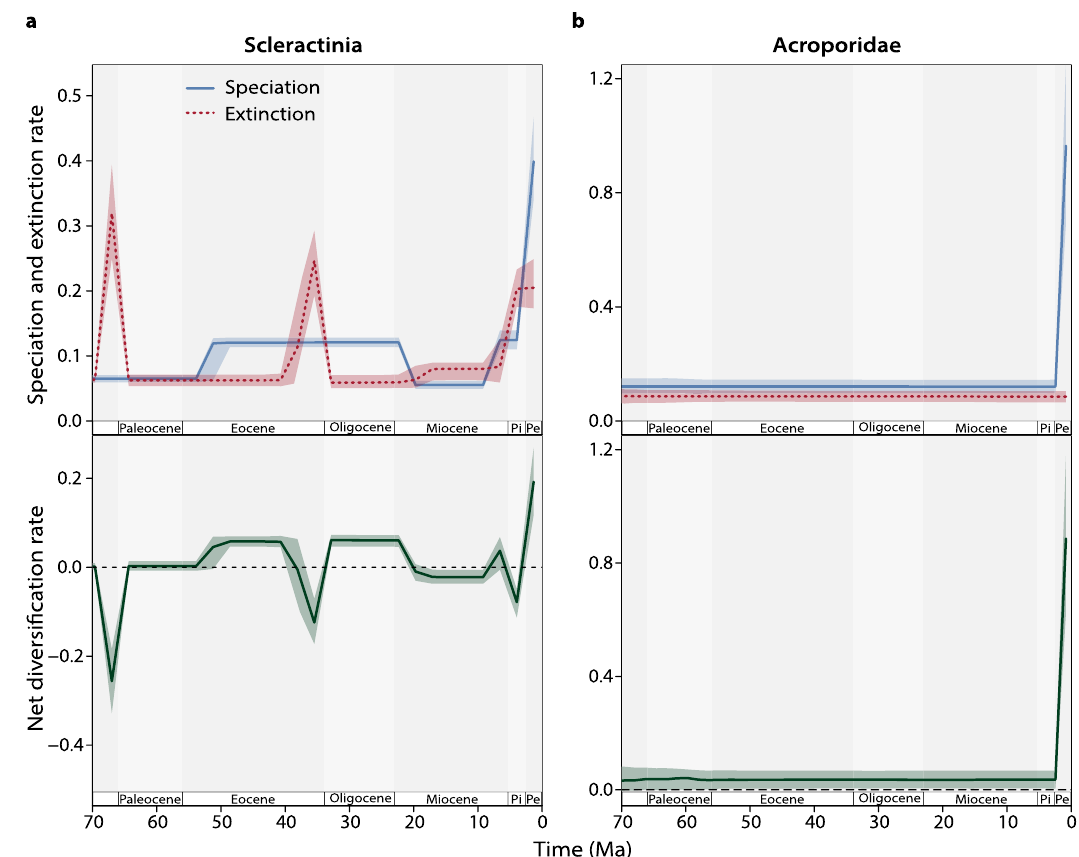
−− Fig. 1 Evolutionary rates through time in scleractinian corals. Rates of speciation (blue) and extinction (red dashed) estimated for fossil lineages of Scleractinia ( a ; n = 4235) and Acroporidae ( b ; n = 165). The analyses incorporate all the fossils recorded in the respective groups, although here we only show the last 70 million years. The resulting net diversi fi cation rates (speciation minus extinction) are shown at the bottom panels. Solid and dashed lines represent the median rates, while coloured shadings represent 95% posterior credibility intervals. Pi — Pliocene; Pe — Pleistocene. Source data are provided as a Source Data fi le.